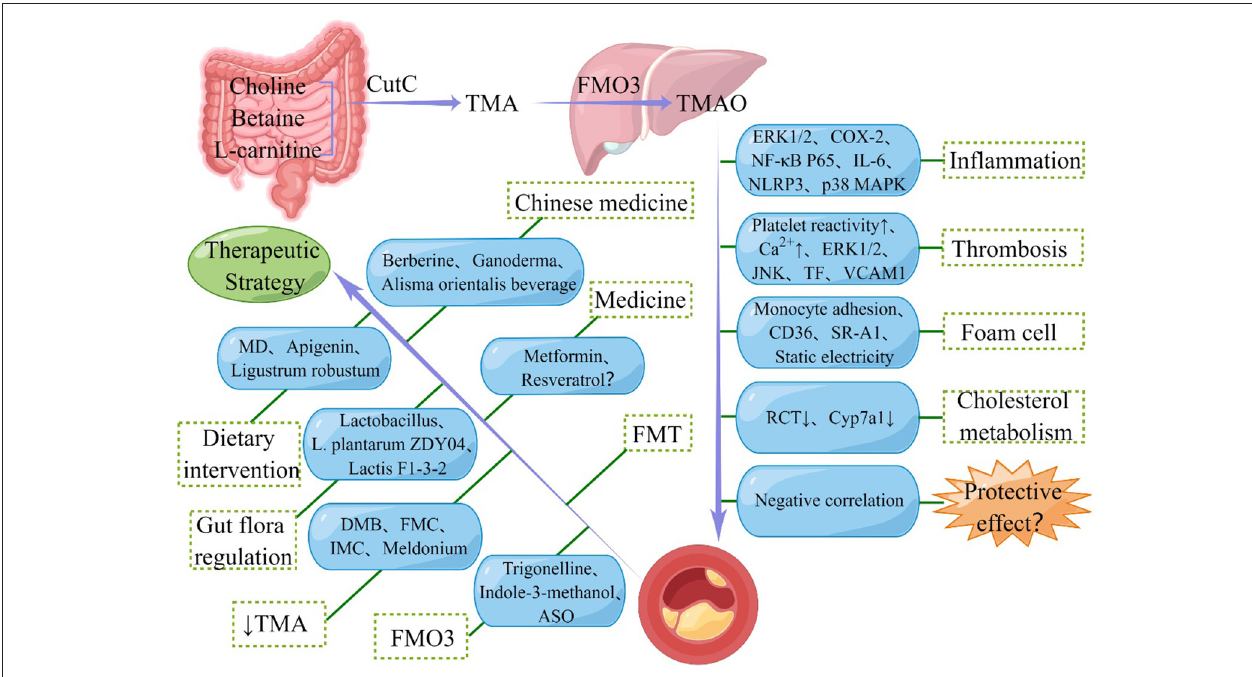
FIGURE 1 | Schematic representation of the relationship between Trimethylamine N-oxide (TMAO) and atherosclerosis (AS). TMAO is synthesized by oxidation of trimethylamine (TMA) produced by gut microbes and promotes the development of AS through various pathways. However, some studies also suggested the protective effect of TMAO in AS. In addition, seven types of therapeutic strategies for alleviating AS targeting TMAO are also shown in the figure. CutC, choline TMA lyase; FMO3, flavin-containing monooxygenase-3; ERK1/2, extracellular signal-regulated kinase 1 and 2; COX-2, cyclooxygenase 2; NF- κ B, nuclear factor kappa-B; IL-6, interleukin 6; NLRP3, nucleotide-binding oligomerization domain-like receptor family pyrin domain-containing 3; MAPK, mitogen-activated protein kinase; JNK, Jun N-terminal kinase; TF, tissue factor; VCAM, vascular cell adhesion molecule; SR-A1, scavenger receptor class A1; RCT, reverse cholesterol transport; Cyp7a1, cholesterol 7 α -hydroxylase; FMT, fecal microbiota transplantation; MD, Mediterranean diet; DMB, 3, 3-Dimethyl-1-butanol; FMC, fluoromethylcholine; IMC, iodomethylcholine; ASO, antisense oligonucleotide.